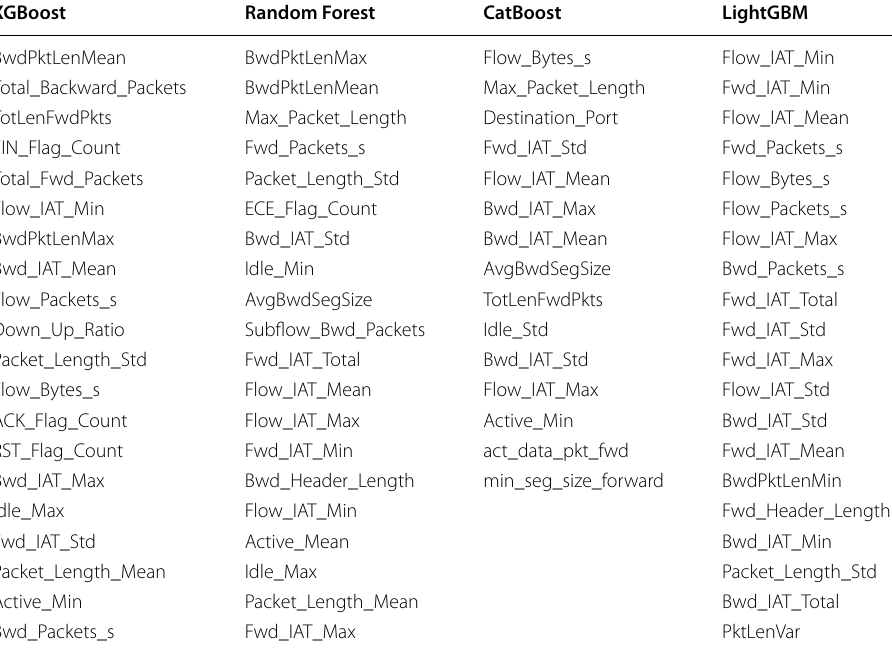
Table 19 Top 20 features for XSS web attacks ranked by Supervised-based Feature Importance Lists